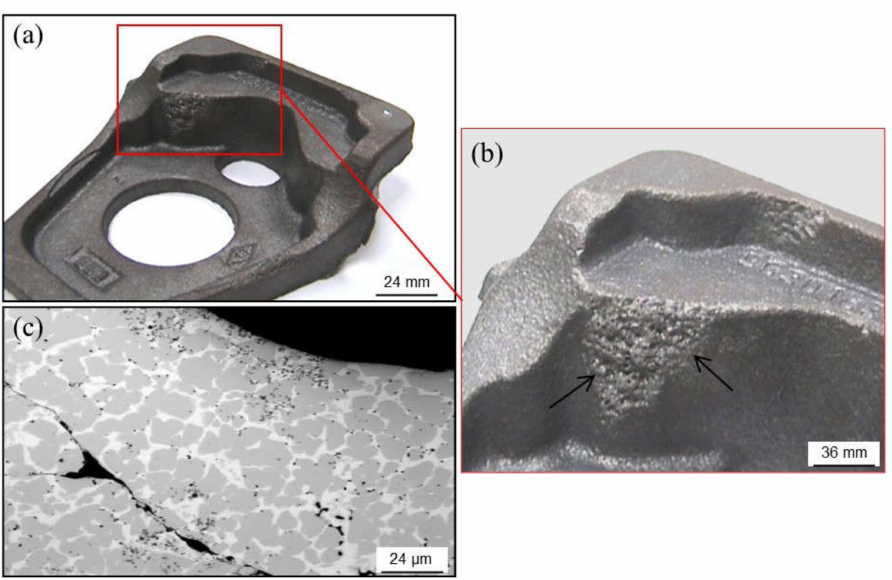
Figure 39. Macroscopic view of a metallic inclusion in a ductile iron casting produced in a vertical molding line with post inoculation ( a , b ). Metallographic view of an inoculant inclusion ( c